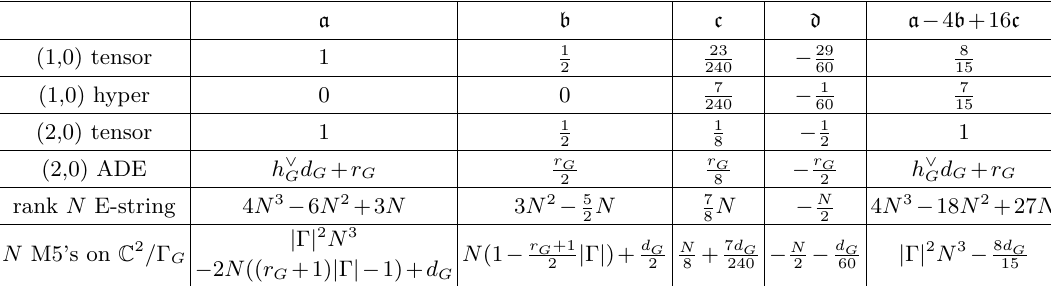
Table 2 . Anomaly coefficients of free multiplets and various SCFTs in